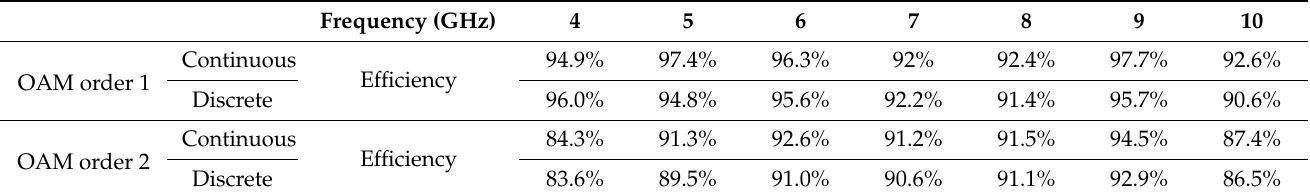
Figure 4. The simulation model of the proposed metasurfaces in continuous phase distribution: ( a ) Table 1. Simulated efficiency of the metasurfaces under different aperture phase Front view of the metasurface generating OAM order of 1. ( b ) Front view of the metasurface gener- ating OAM order of 2. ( c ) Detailed view of the metasurface generating OAM order of 1. ( d ) Detailed view of the metasurface generating OAM order of 2.